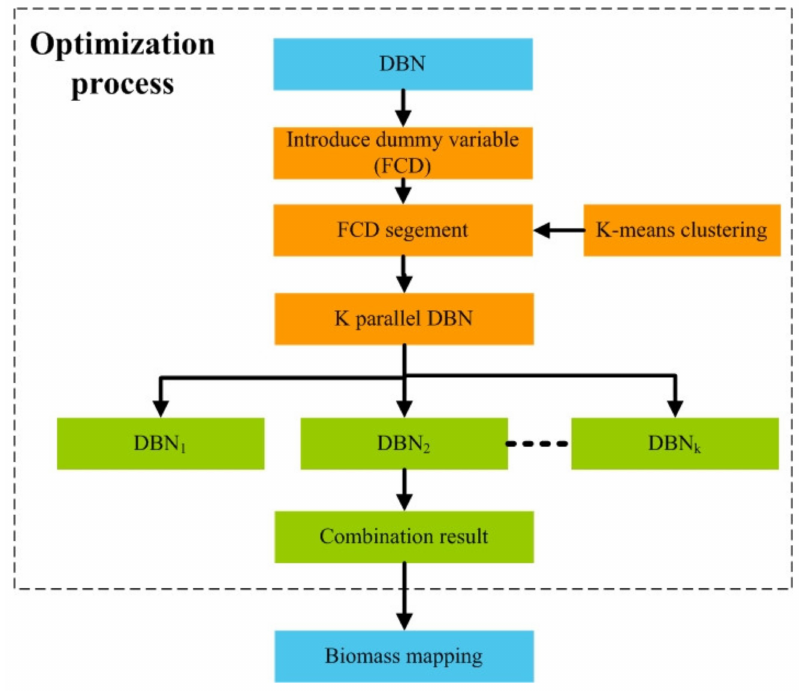
Figure 6. The workflow of the K-DBN model.